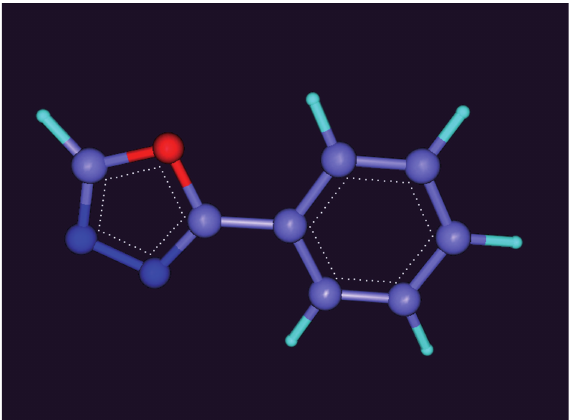
F 1: Template (ball and stick).